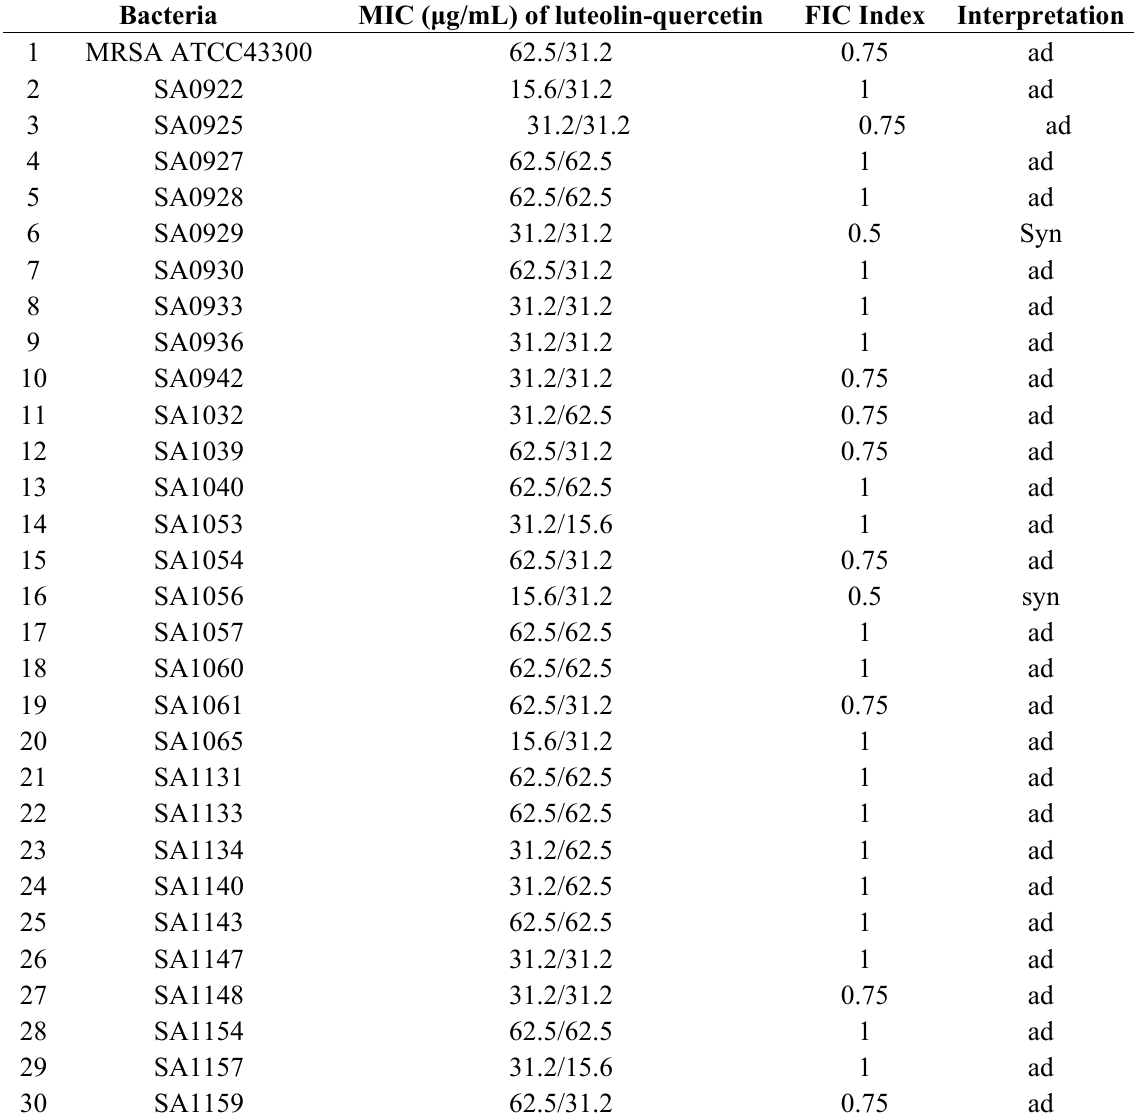
Table 2. FIC indexes of two-drug combination of luteolin-quercetin against 30 MRSA